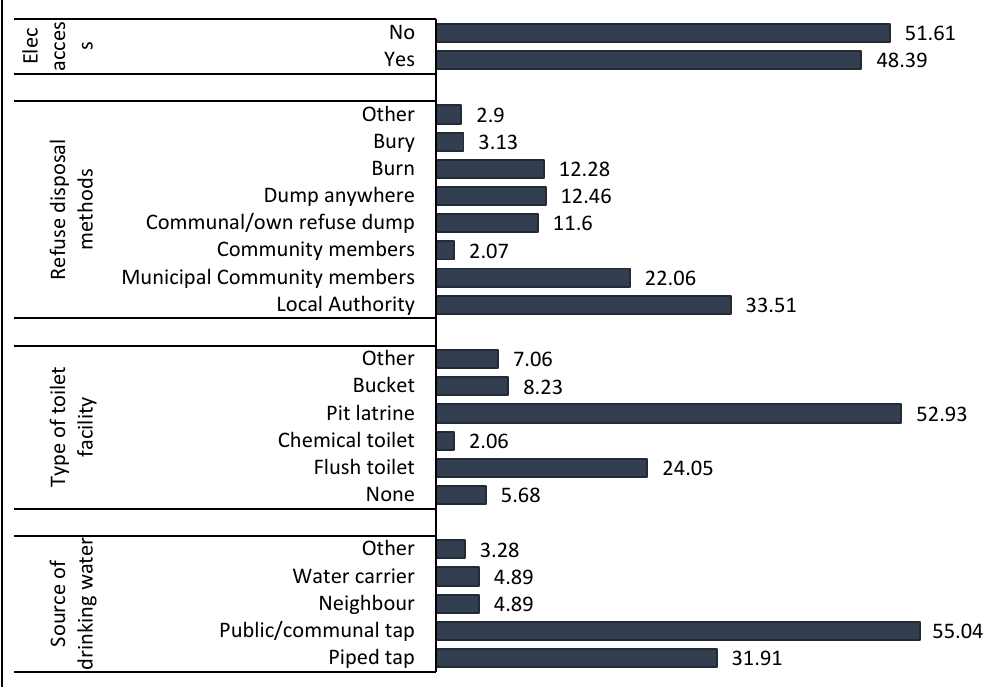
Figure 2. Access to basic services in informal settlements in South Africa.